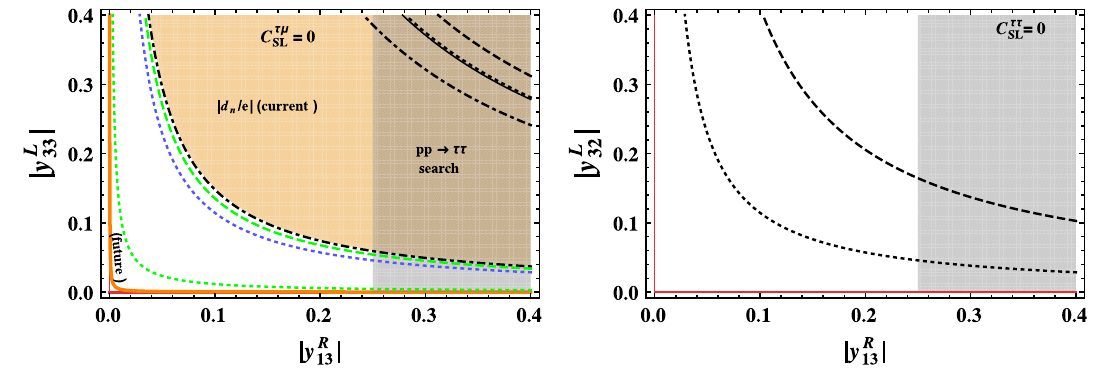
Fig. 4 Similar to Fig. 3 but for B ( B → τ ¯ ν) . The contours types and color schemes are basically same as in Fig. 3 except for one additional blue dotted contour, which represents the Belle central value for purely imaginary phase ( φ ττ = π/ 2). The orange shaded region and the thick